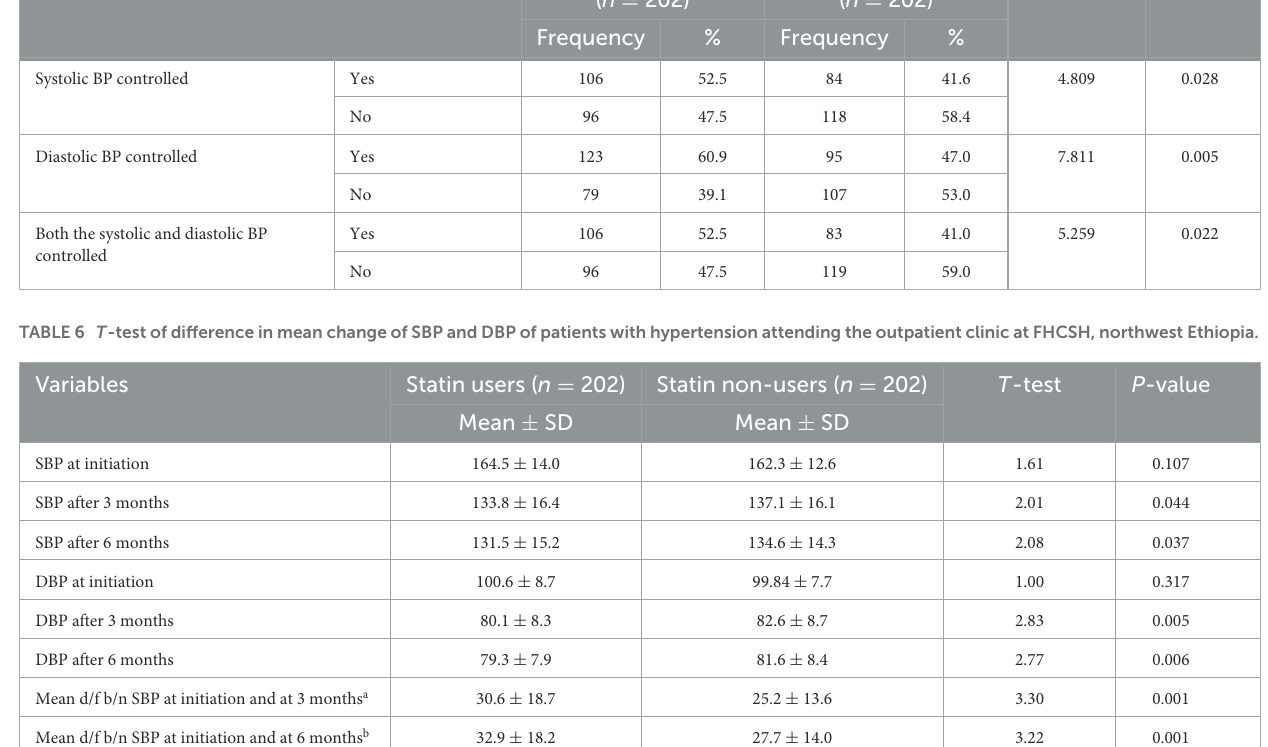
TABLE 5 Blood pressure control status of patients with hypertension attending the outpatient clinic at FHCSH, northwest Ethiopia. Variables